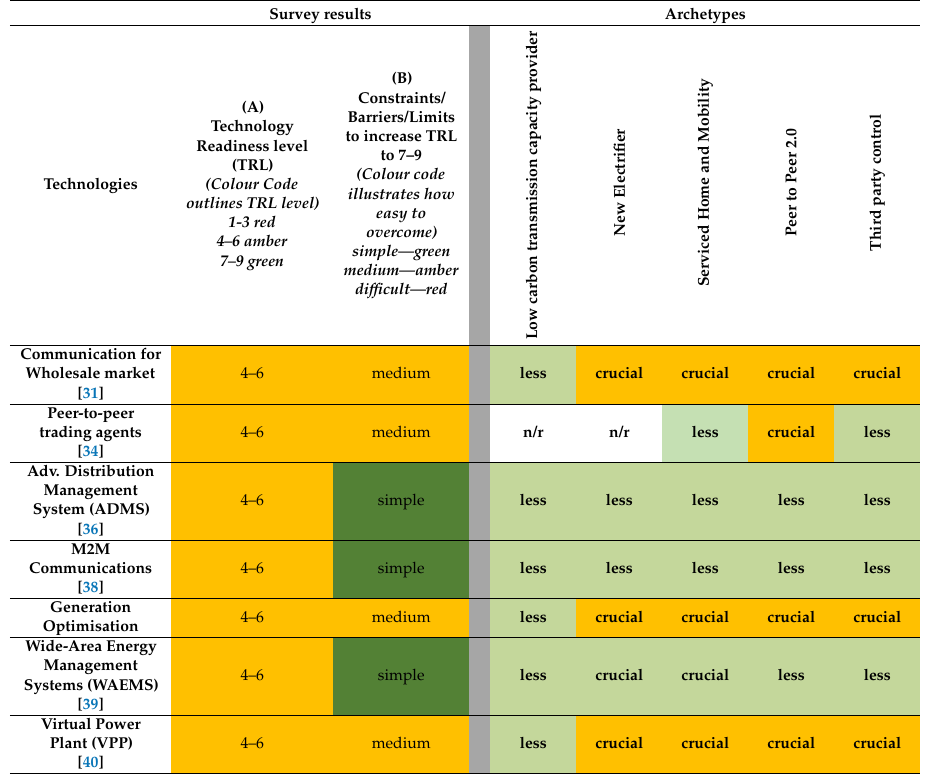
Table 6. Technological barriers that need to be overcome for future energy systems business